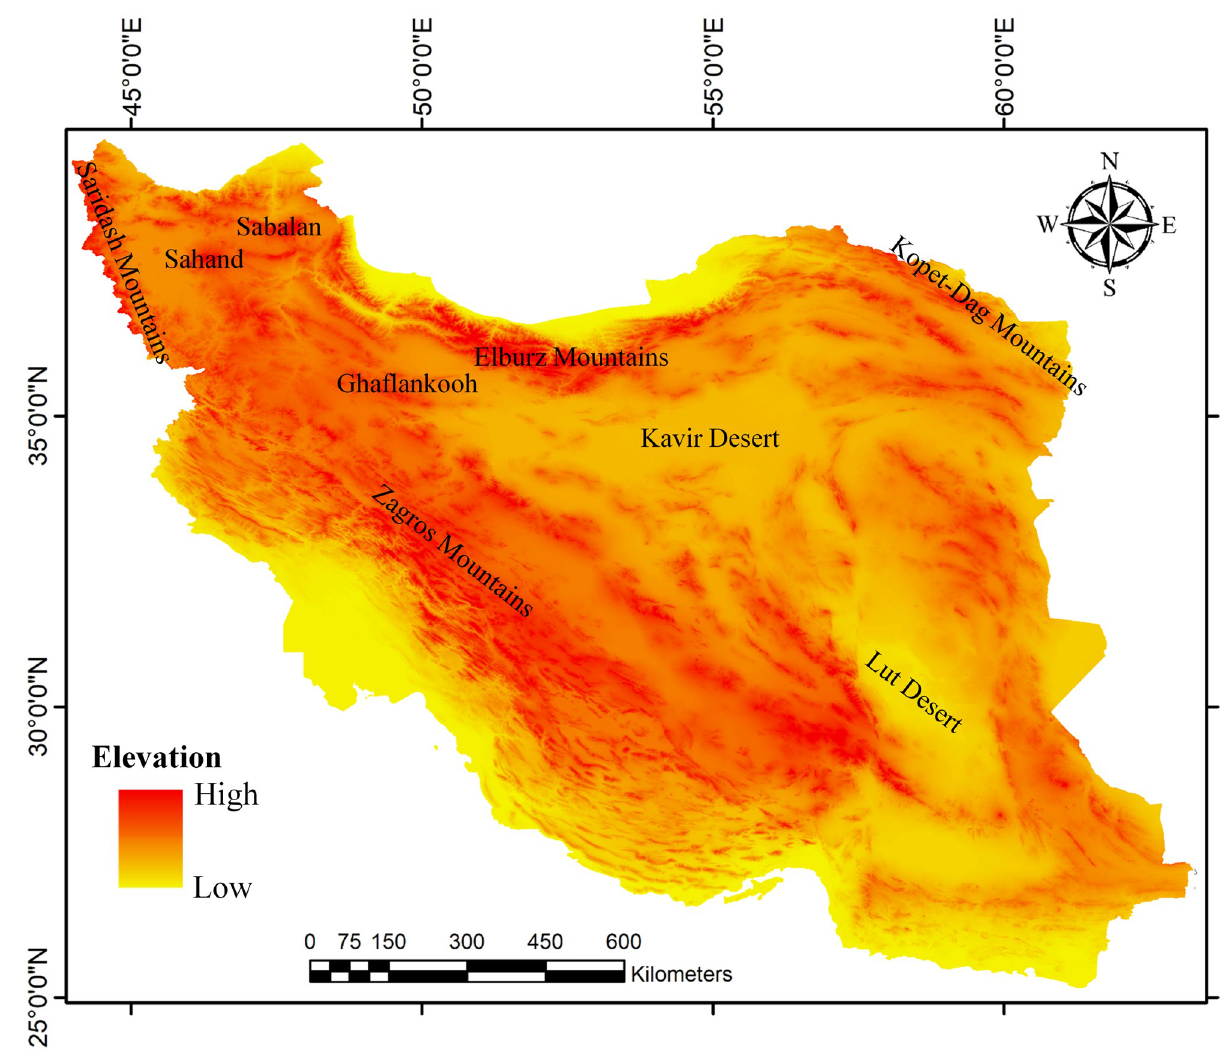
Fig 1. Tepographic map of Iran showing the main Iranian regions as suitable inhabitation areas and corridors for the great gerbil.